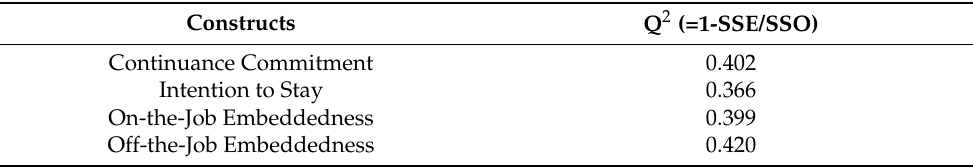
Table 6. Construct Cross Validity